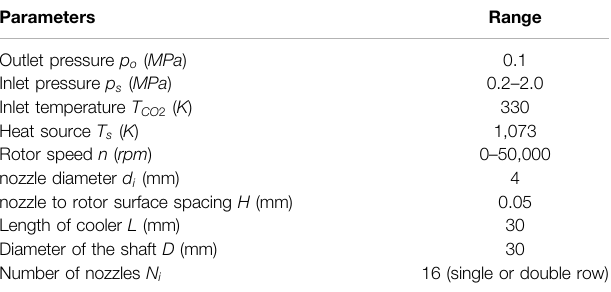
TABLE 2 | Correlation coef fi cients between the average Nusselt number and the variables analyzed. Correlation Coef fi cient Parameters Double Row Single